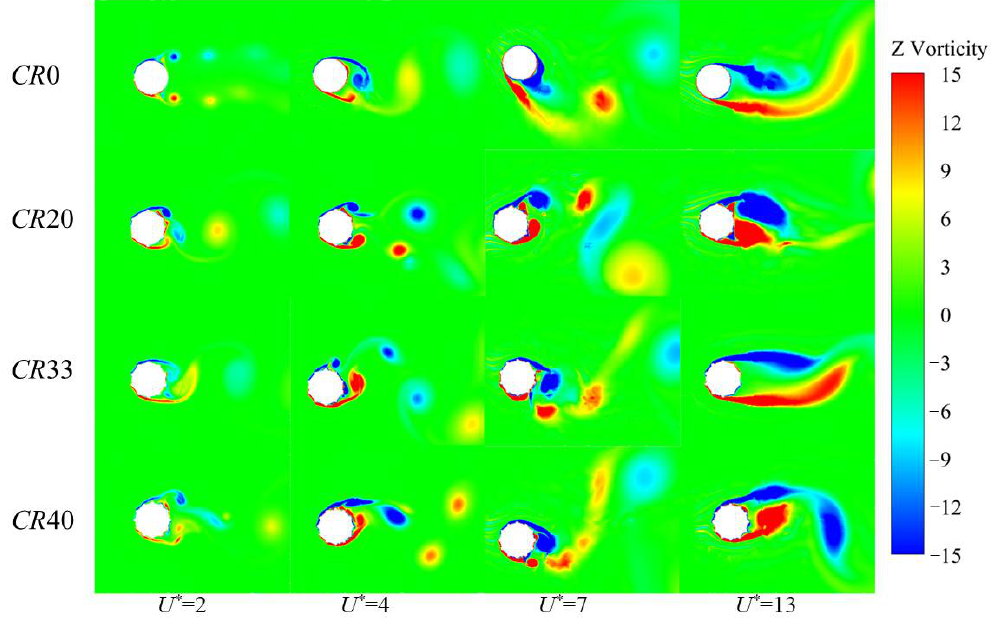
Figure 21. Vorticity contours for a cylinder with different coverage ratios at selected reduced velocities